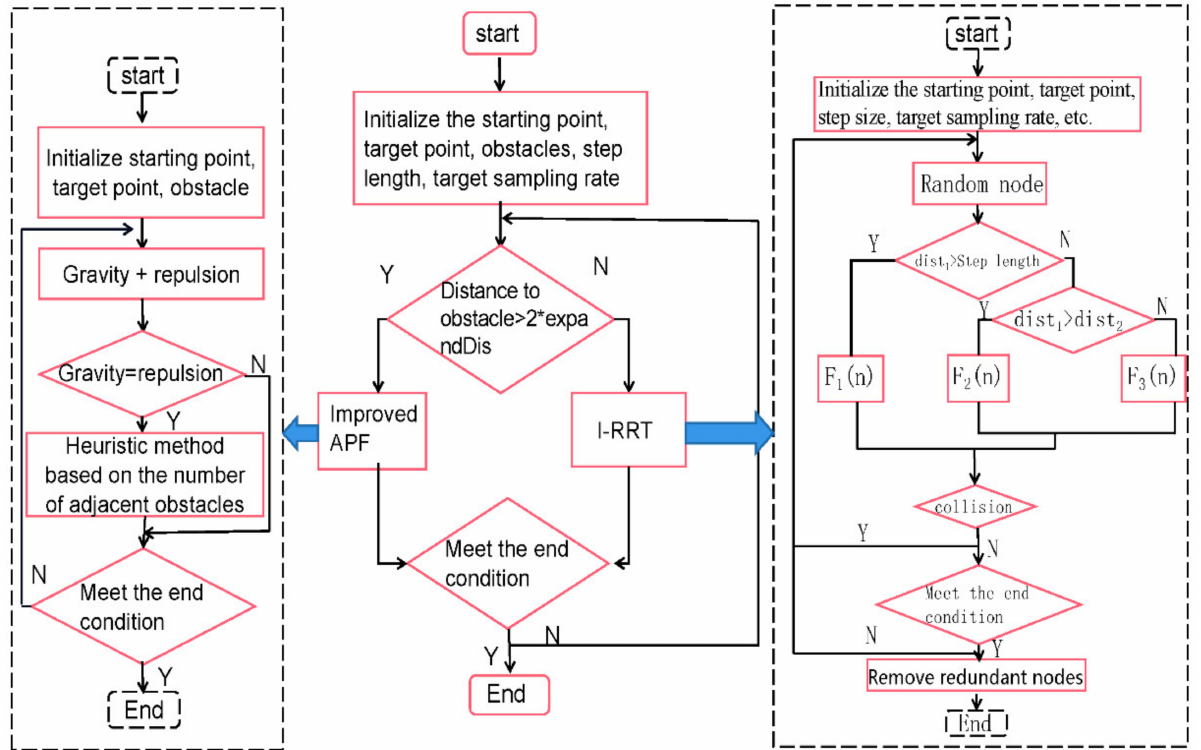
Figure 8. APF-RRT algorithm flow